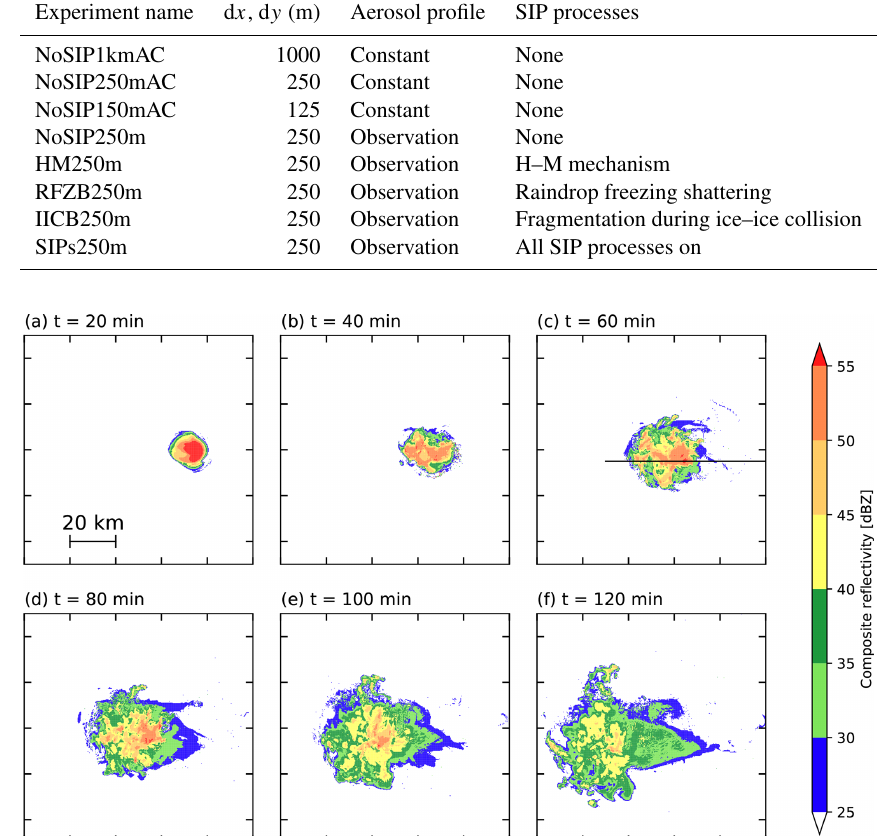
Figure 2. Composite reflectivity (dBZ) in SIPs250m at (a–f) t = 20, 40, 60, 80, 100, and 120min, respectively. The black solid line in (c) indicates the location of cross section shown in Fig. 7. Tick marks are included every